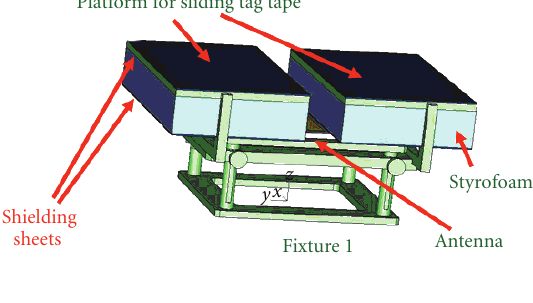
Figure 2: The proposed fixture.